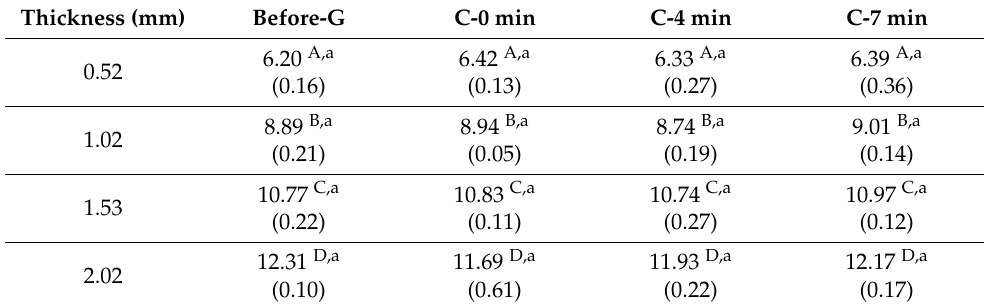
Table 8. OP as a function of cooling rate for specimens with various thicknesses (mean ±